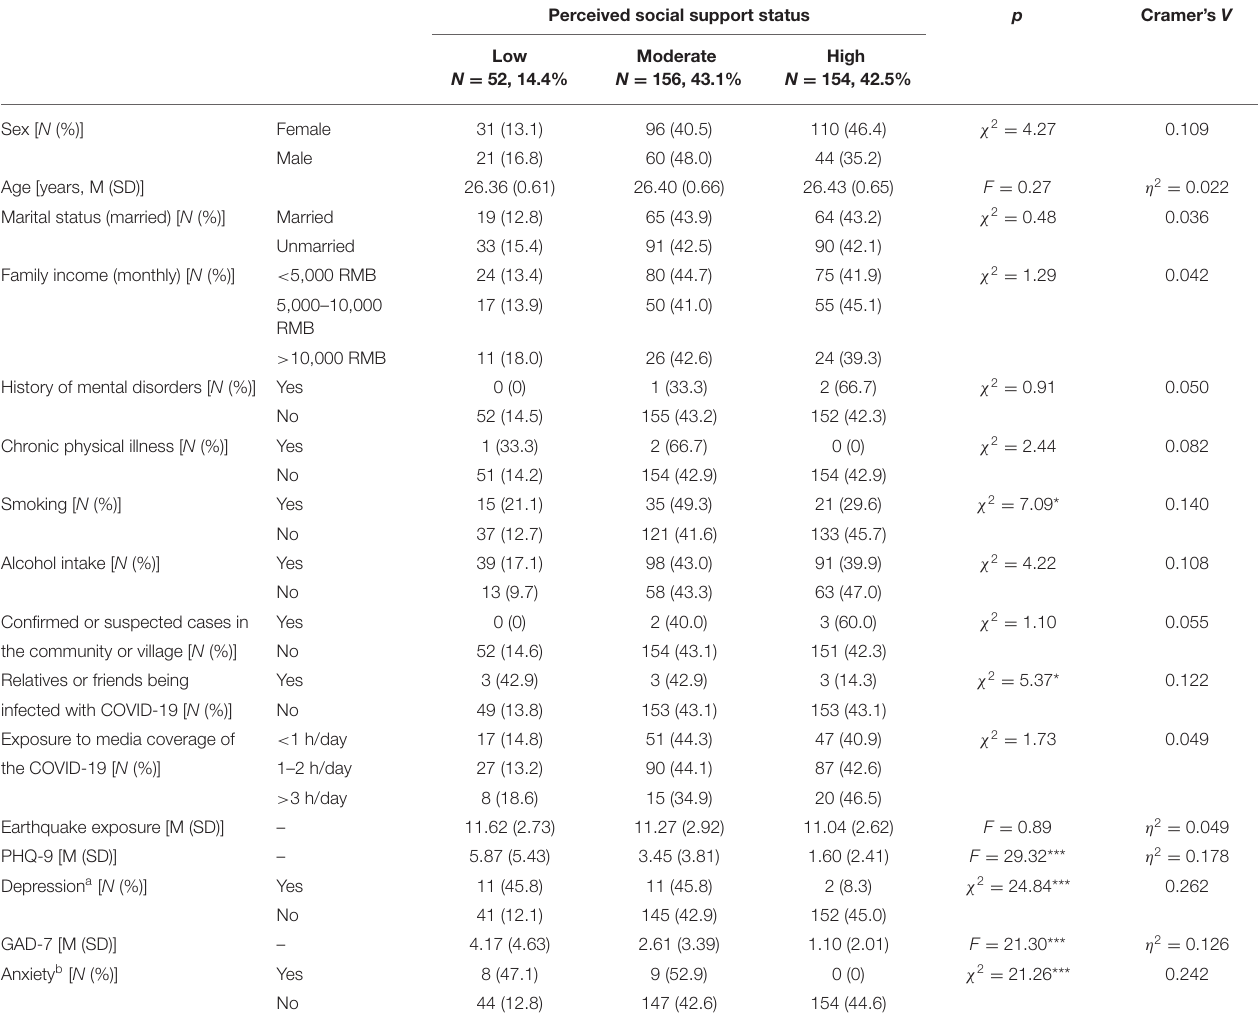
TABLE 2 | Characteristics of participants enrolled to the study according to perceived social support status.